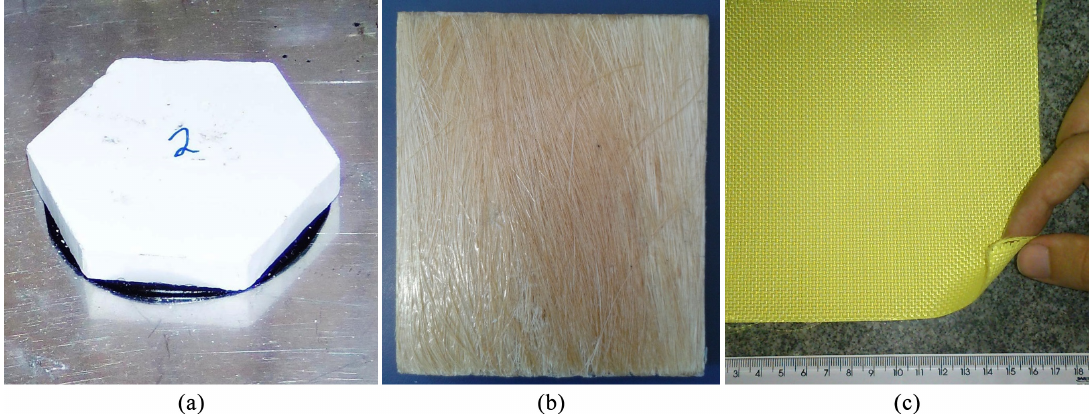
Figure 1. Components used in the investigated multilayered armor: (a) ceramic plate; (b) sisal composite plate and (c) aramid fabric